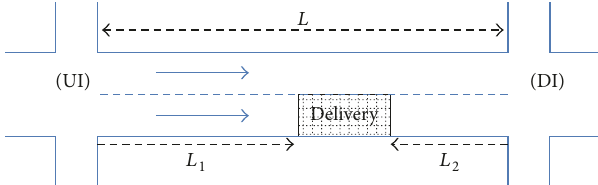
Figure 1: General situation of the DDPS on a given link between the upstream intersection (UI) and the downstream intersection (DI). Notice that, in this example, a 2-lane street is presented, but the methodology is generalized to any number of lanes 𝑛 ( 𝑛 ≥ 2)